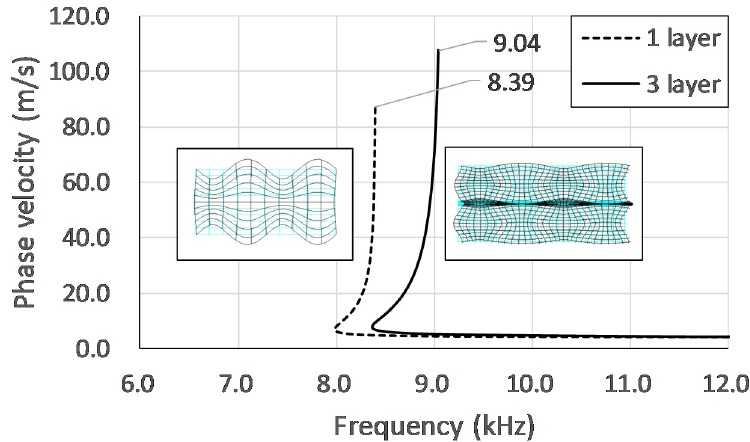
Figure 14. Theoretical dispersion curves and the corresponding mode shapes for the S1 mode of the one ‐ layered slab and for the 6th mode of the three ‐ layered composite plates with the same top layer